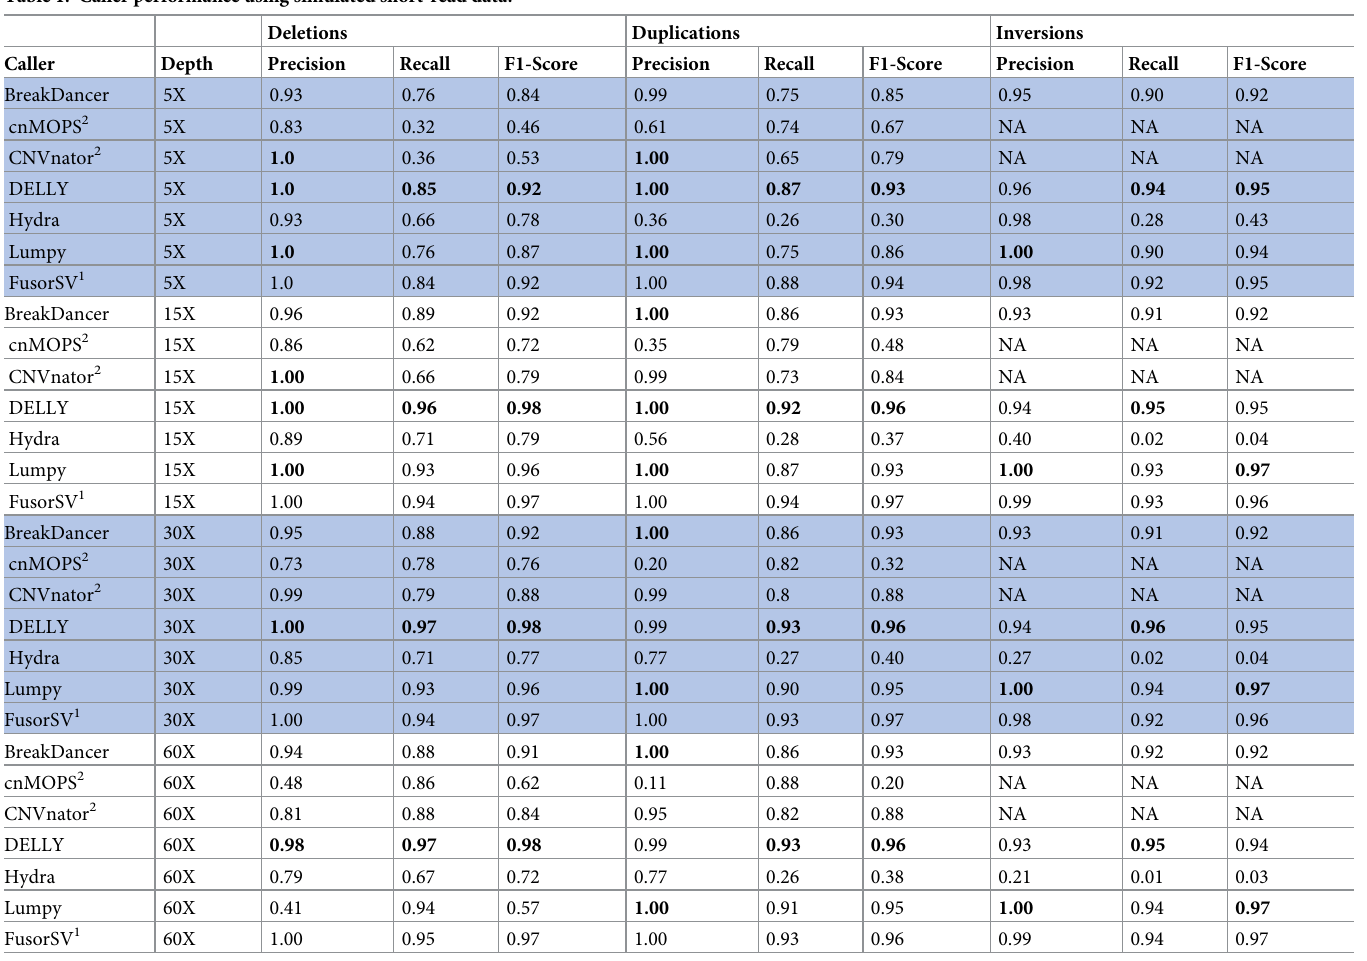
Table 1. Caller performance using simulated short-read